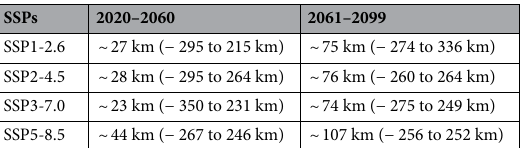
ary of the EASM. Figure 3 shows the meridional migration of the EASM northern boundary in different regions during the twenty-first century compared to the present